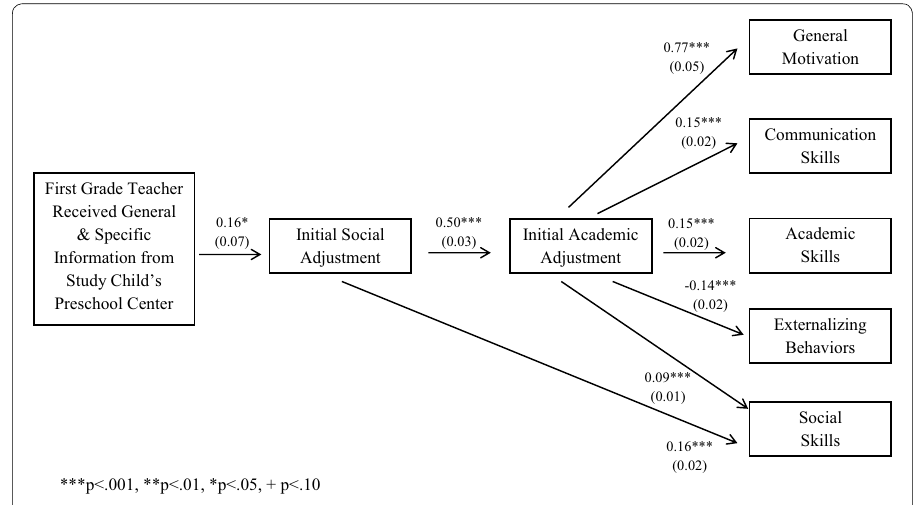
Fig. 2 Teacher-center contact and child outcomes mediation model with direct